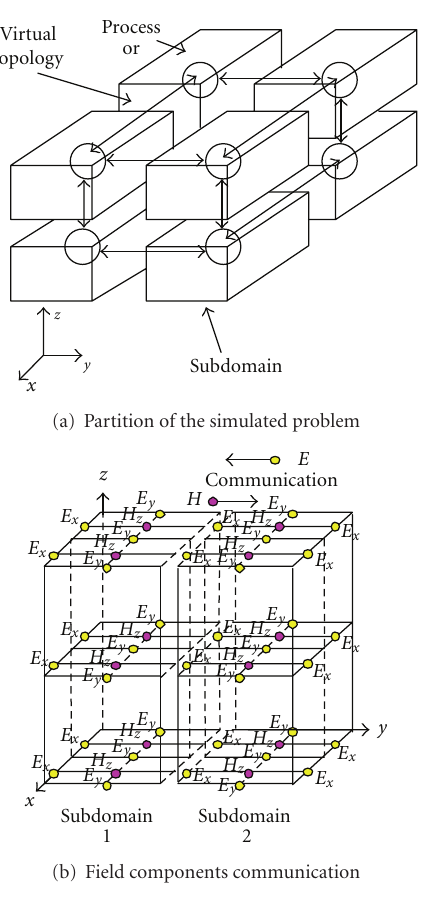
Figure 1: Division and communication of Parallel FDTD in 3D.